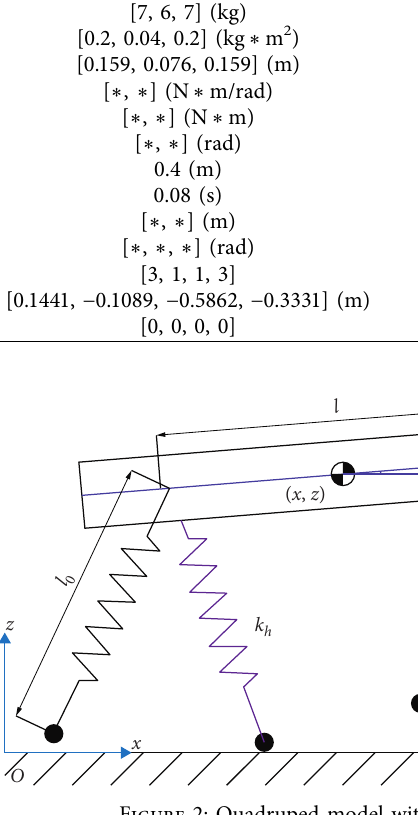
Figure 2: Quadruped model with rigid